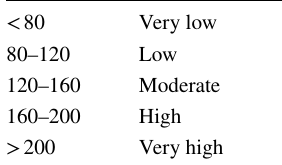
Table 2 Criteria of the degrees of vulnerability. (Reproduced with the permission from Civita and De Regibus 1995; Corniello et al.